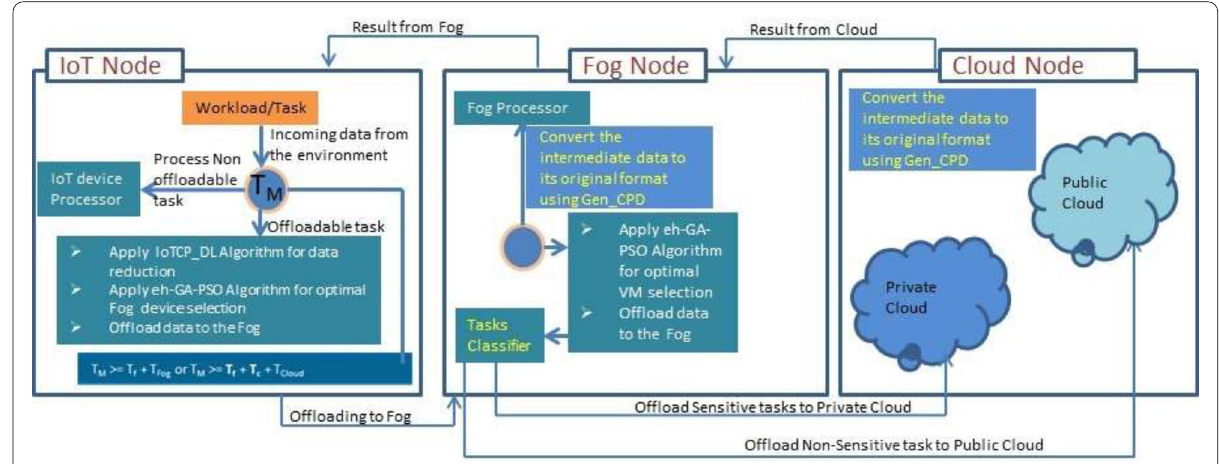
Fig. 8 Generalized system model of the proposed attribute reduction based secured offloading